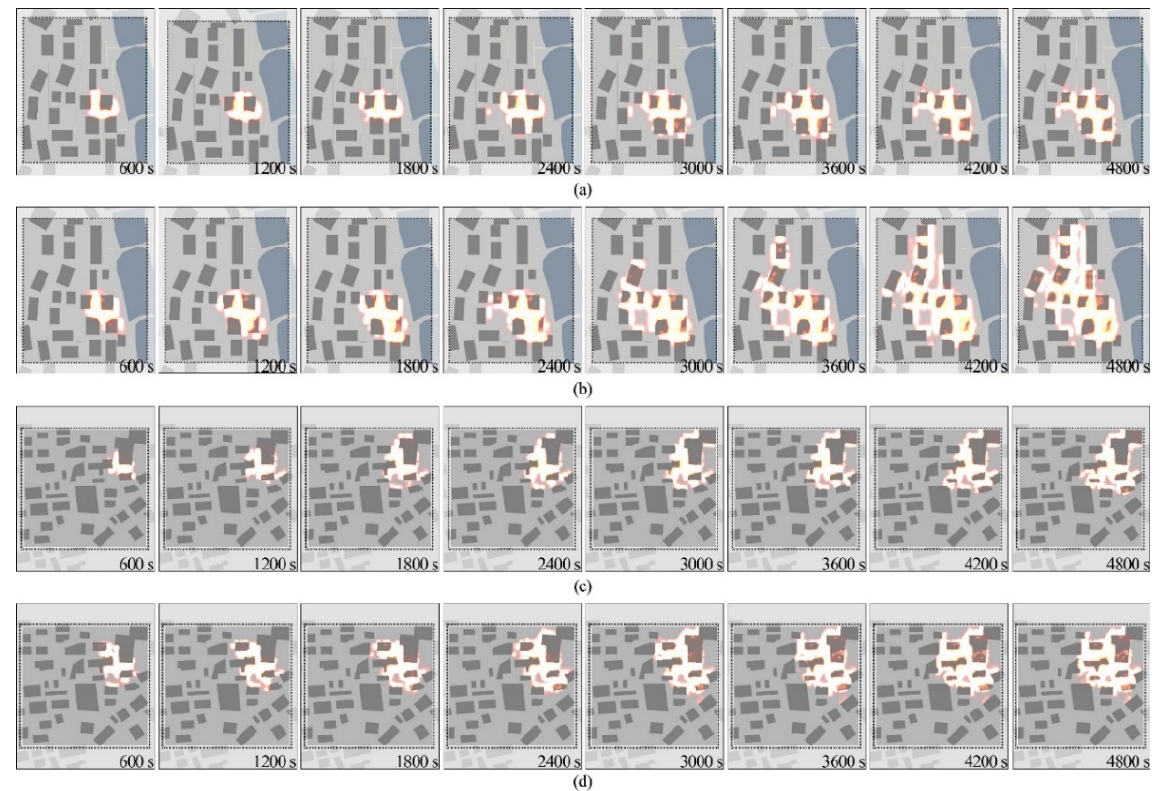
Figure 17. Fire simulation results for different village layouts. ( a ) Shujiatang Village with a mild north wind (0.67 m/s); ( b ) Shujiatang Village with a strong north wind (2.28 m/s); ( c ) High chair Village with a mild northeast wind (0.67 m/s); and ( d ) High chair Village with a strong northeast wind (2.28 m/s).